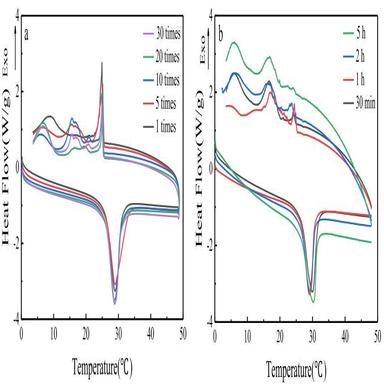
DSC curves of cross-linked PVA / PCM fibers after (a) washing and (b) soaking in hot water.